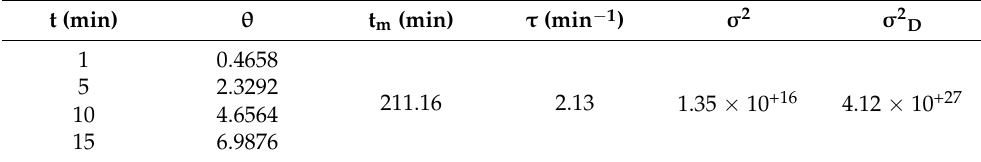
Table 3. Results of residence time distribution of Nanofiltration